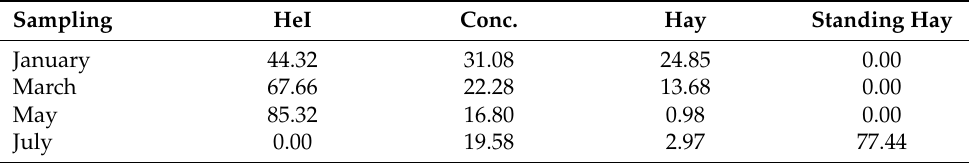
Table 2. Average contribution (%) of different feed types (HeI = fresh herbage intake, Conc. = concentrate) to the flocks’ diet throughout the milk production season, considering 11 commercial Sarda ewe farms.